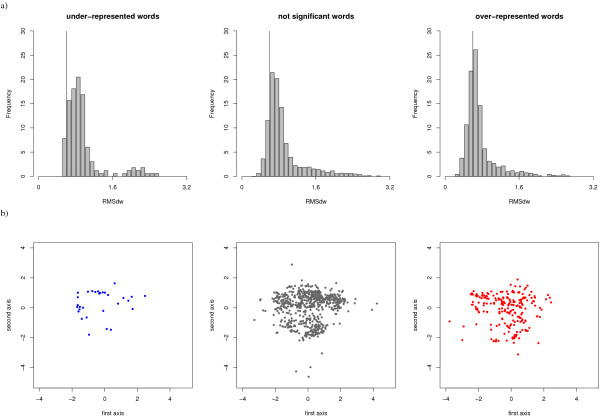
Structural variability of the three statistical word types of Wset≥30. a) Intra-word structural variability: distribution of the RMSdw. The vertical line corresponds to a threshold of 0.6 Å b) Inter-word structural variability: Sammon's map computed from the RMSddev for a sample of 890 words of Wset≥30. All the points are subjected to the same projection and plotted on distinct plots.